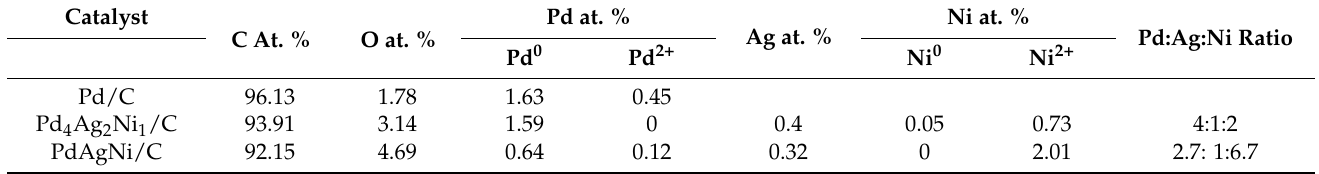
Table 3. XPS surface atomic concentration of C, O, Pd, Ag, and Ni in Pd/C, Pd 4 Ag 2 Ni 1 /C, and PdAgNi/C. Catalyst Pd at. % Ag at. % Ni at. % C At. % O at. %